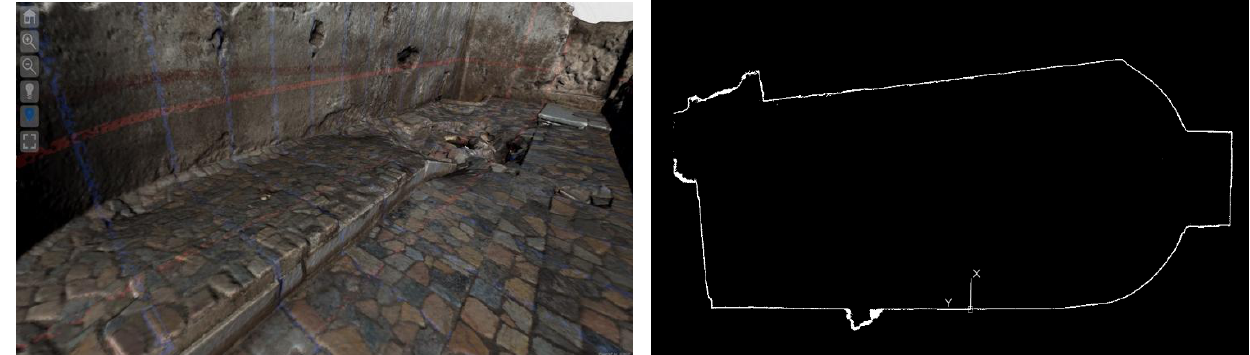
Figure 11. 3D Model Hotspots, Geometric Features Extraction (a), Plan, Point Cloud Section (b)